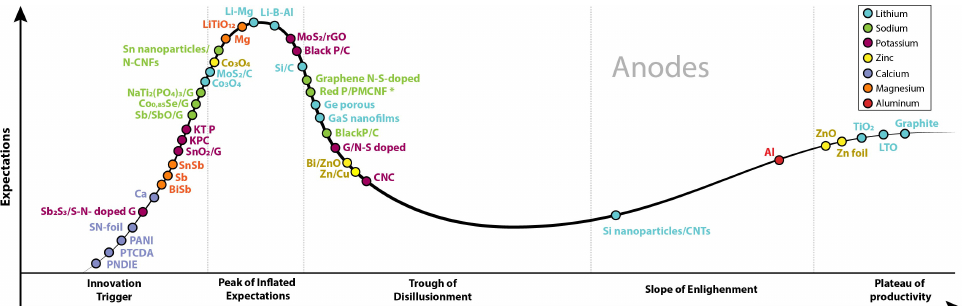
Figure 14. Graph constructed by the authors from Gartner hype cycle for promising anodes materials for batteries. Materials are grouped according to the seven battery types: Li, Na, K, Zn, Ca, Mg, and Al. Each material is organized into a stage according to the estimation of development among innovation and productivity stage.